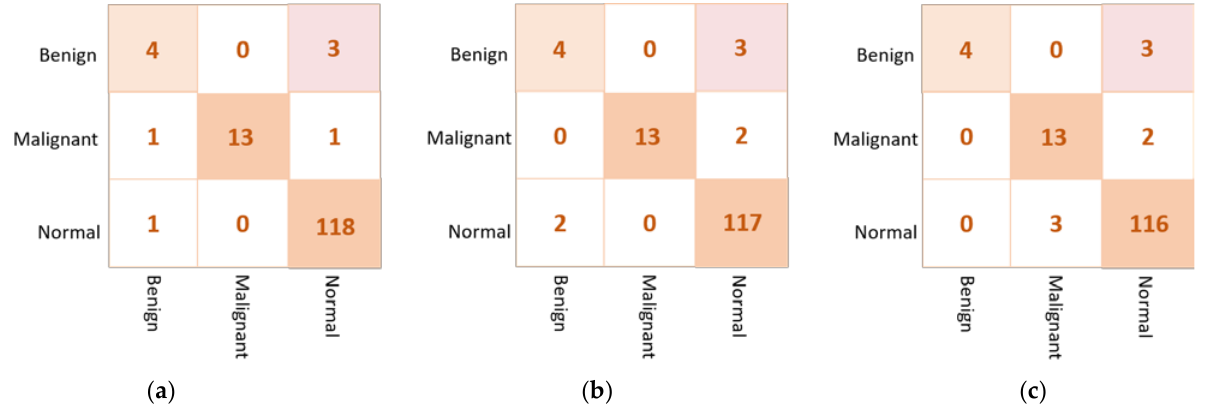
Figure 9. Confusion matrices of the best three individual models for the multi-classification approach: ( a ) VGG16, ( b ) Xception, and ( c ) DenseNet201.